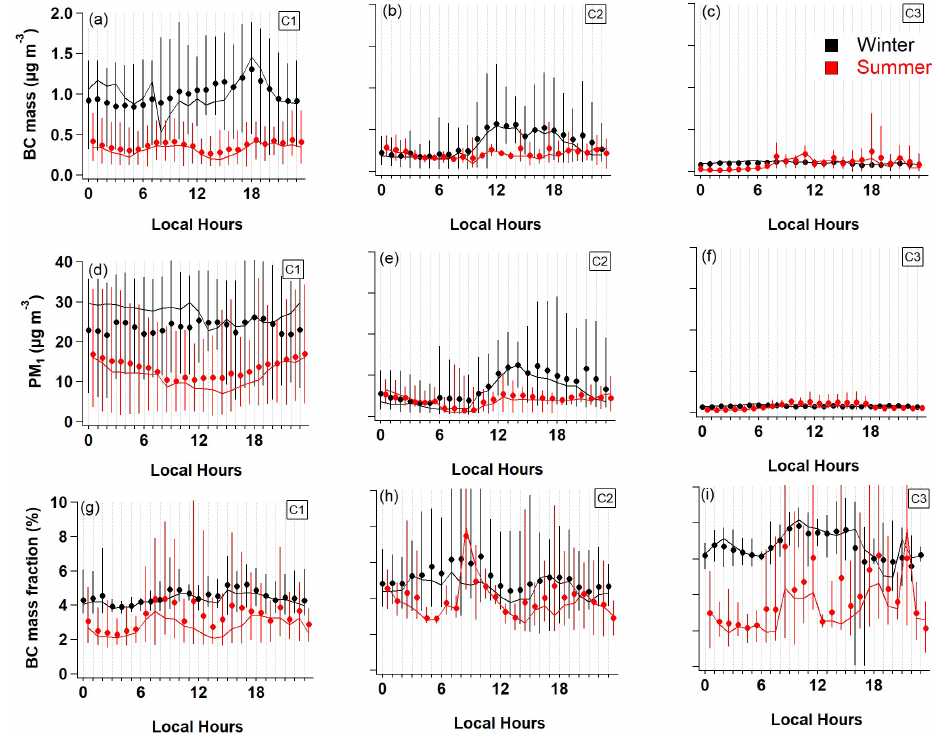
Figure 4. Diurnal variation of BC mass (a–c) , PM 1 (d–f) and BC mass fraction (g–i) for the three PBL types in both seasons, where black and red denote the winter and summer, respectively. The solid circles, lines and whiskers denote the mean, median, and 25th and 75th percentiles,